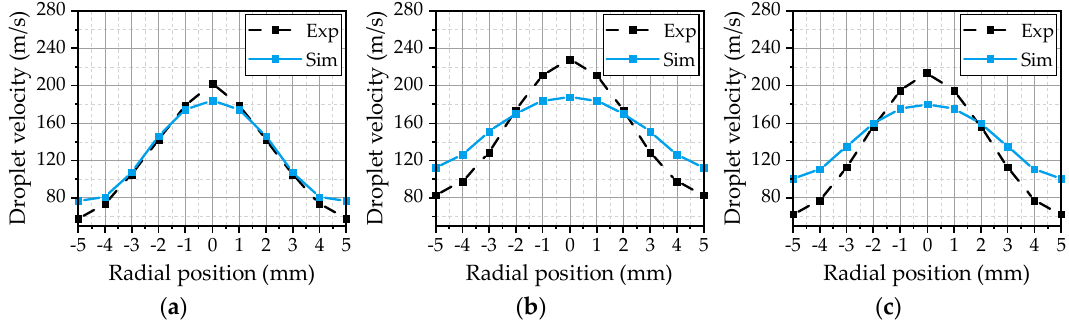
Figure 10. Simulated and measured radial profiles of the mean droplet velocity for all droplets with a diameter greater than 15 μ m for OP 1 ( a ), OP 2 ( b ) and OP 3 ( c ).